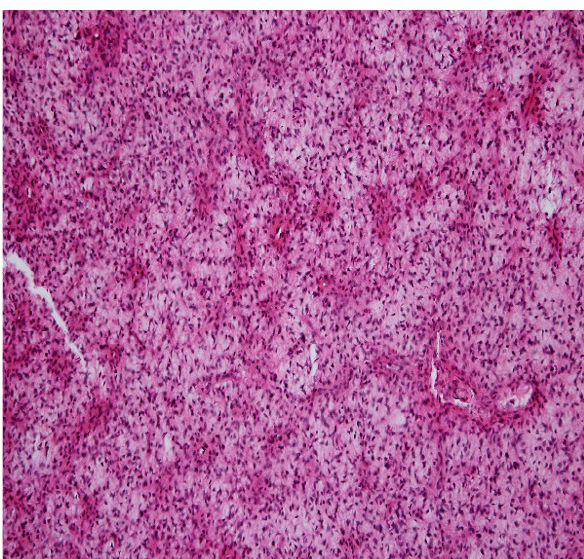
Fig. 3. Microscopic view of the tumor resected from Patient 2, 100x